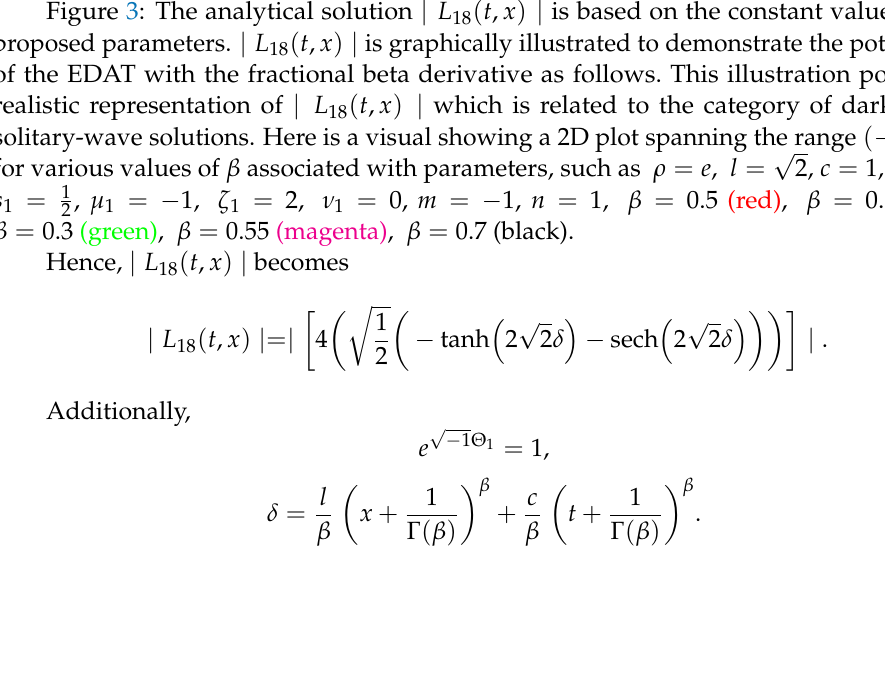
Figure 2. The 2D graphs of dark, singular solitary-wave solution, i.e., | L 10 | across different values of β . Figure 3: The analytical solution | L 18 ( t , x ) | is based on the constant values of the proposed parameters. | L 18 ( t , x ) | is graphically illustrated to demonstrate the potentiality of the EDAT with the fractional beta derivative as follows. This illustration portrays a realistic representation of | L 18 ( t , x ) | which is related to the category of dark–bright solitary-wave solutions. Here is a visual showing a 2D plot spanning the range ( − 0.2, 0.2 ) for various values of β associated with parameters, such as ρ = e , l = s 1 = 1 , µ 1 = − 1, ζ 1 = 2, ν 1 = 0, m = − 1, n = 1, β = 0.5 (red), β = 0.6 (blue), 2 β = 0.3 (green), β = 0.55 (magenta), β = 0.7